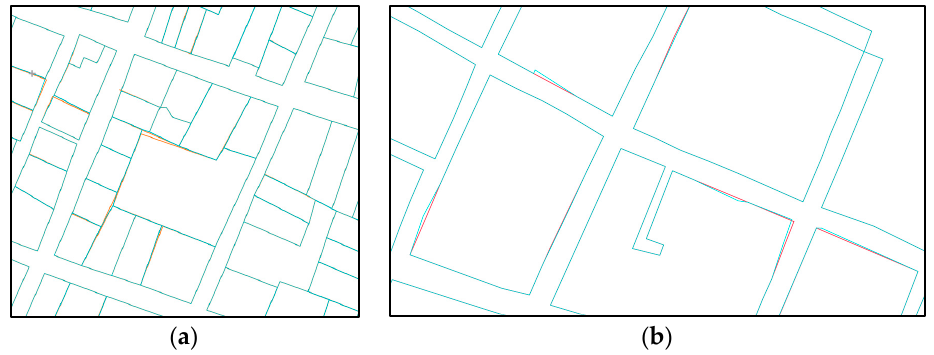
Figure 23. Deviations between ( a ) the initial crowdsourced land parcels and the edited land parcels by the professional-crowdsourced land parcels (green), edited land parcels (orange), ( b ) the initial road network and the edited road network by the professional-crowdsourced road network (light blue), edited road network (red).